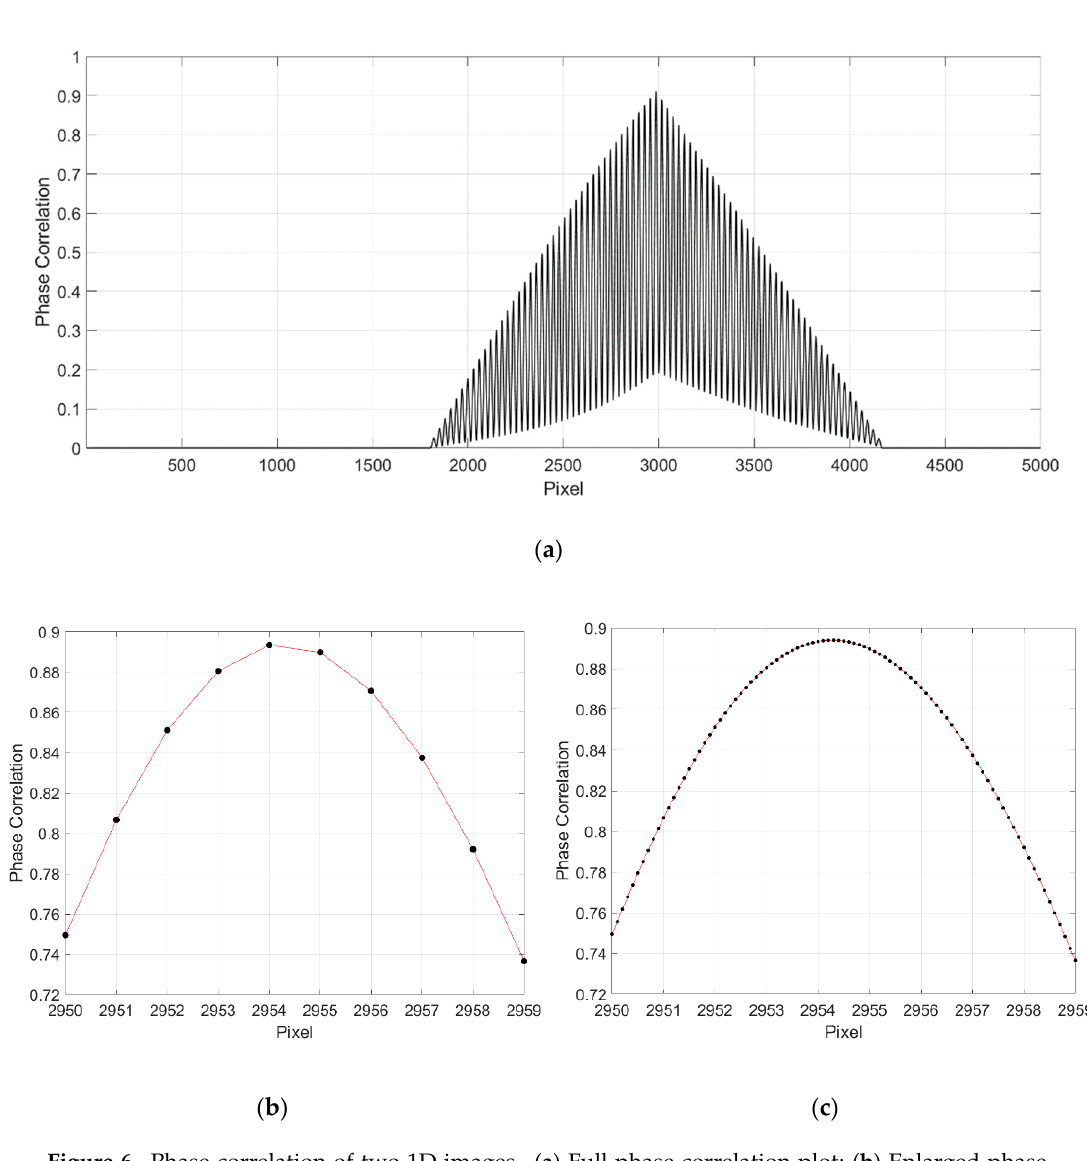
Table 1. Registration speed and accuracy comparison between 1D and 2D single ‐ step discrete Fourier transform (SSDFT) methods.